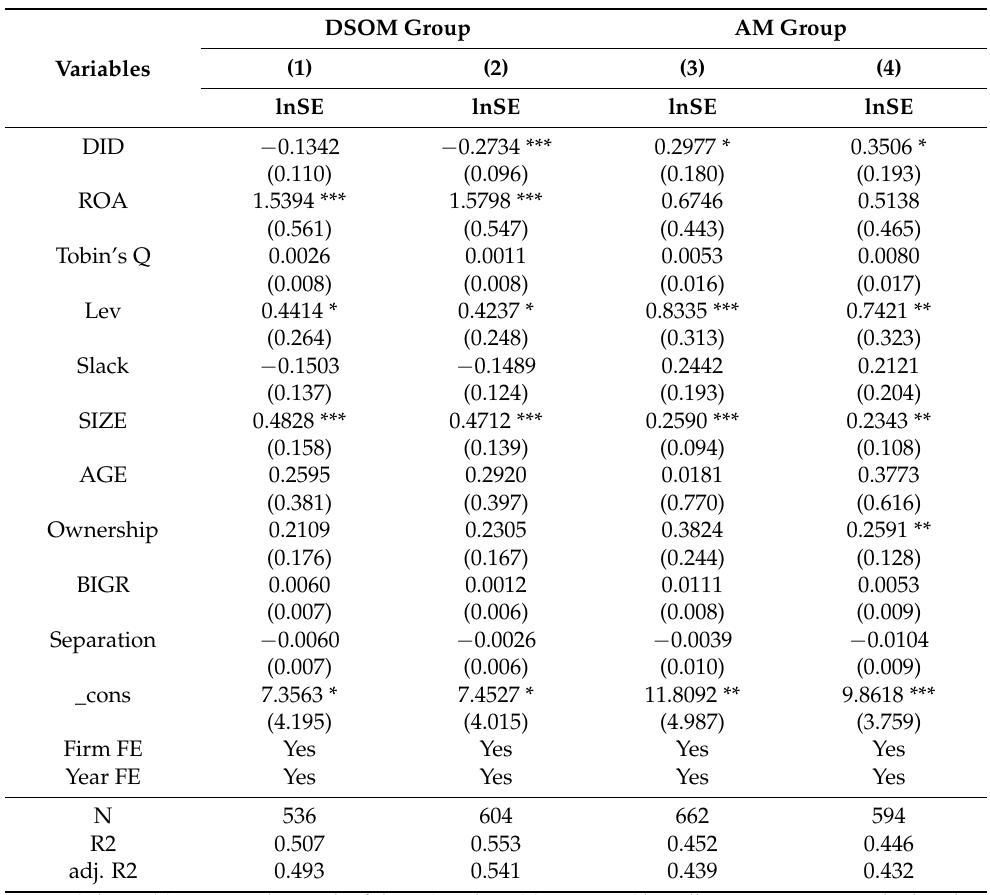
Table 5. Auxiliary